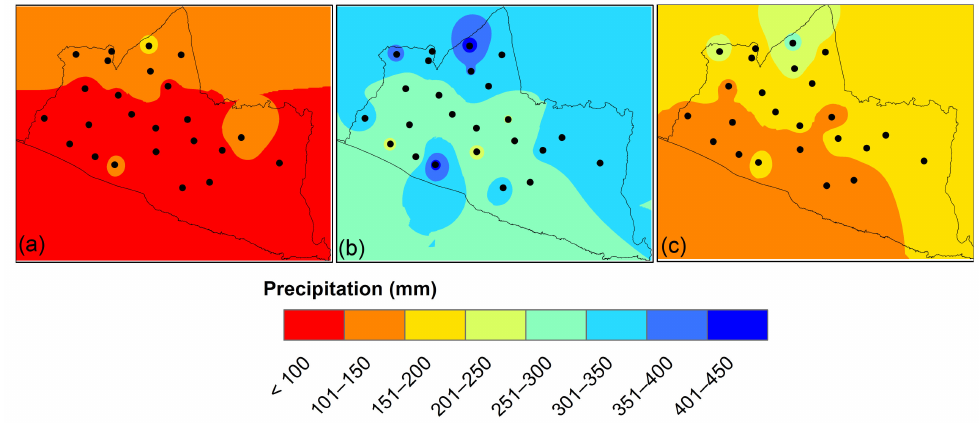
Figure 4. Clustered rainfall stations classified into four groups based on ( a ) dry season; ( b ) rainy season; ( c ) inter-monsoon season.